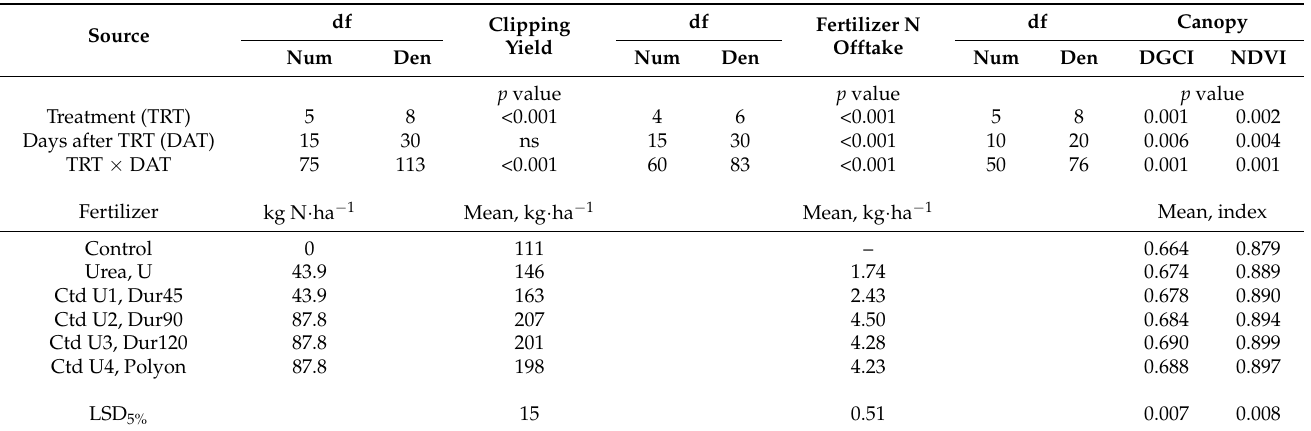
Table 2. ANOVA of Kentucky bluegrass clipping yield, fertilizer N offtake, and canopy vegetative indices by source, and main effect (pooled) means by treatment